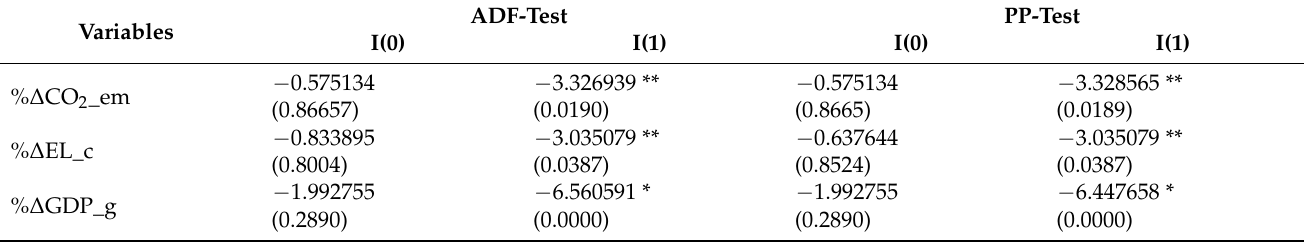
Table 8. Test of Unit Root.